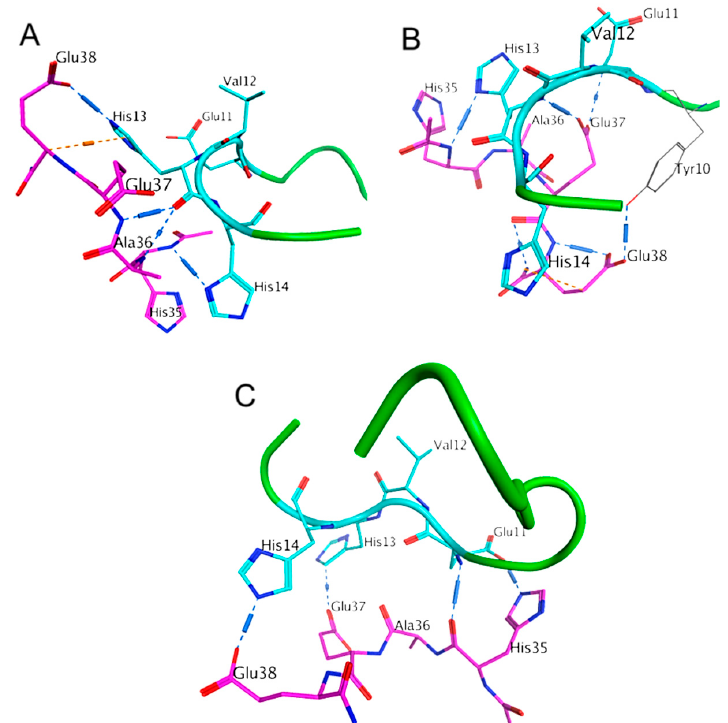
Figure 4. Global docking of Ac-HAEE-NH 2 to A β 16 ( A ) and ( B ) Examples of the docked Ac-HAEE-NH 2 peptide. The A β 16 peptide is colored green with the 11 EVHH 14 site shown in cyan, and the Ac-HAEE-NH 2 tetrapeptide is colored magenta. ( C ) The proposed interface of HAEE-EVHH interaction based on a docking model.